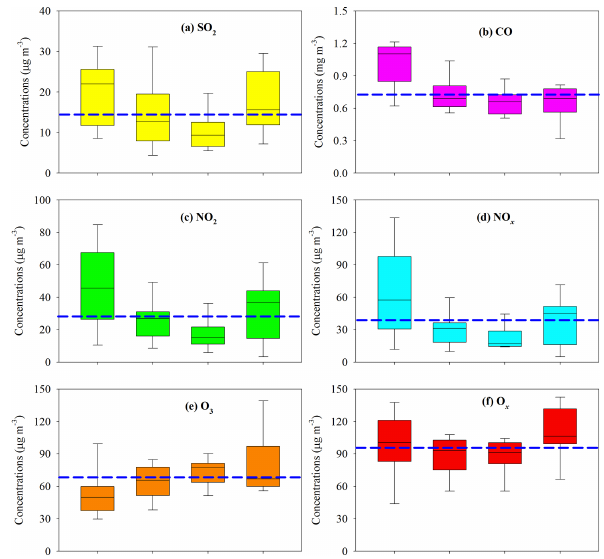
Figure 3. Seasonal variation of gaseous pollutants in the PRD. The boxes with error bars represent the 10th, 25th, 75th, and 90th percentiles for each pollutant. The line in each box represents the median value. The blue dashed lines indicate the annual av- erage concentrations of SO 2 (14.9µgm − 3 ) , CO (0.74mgm − 3 ) , NO 2 (28.5µgm − 3 ) , NO x (39.0µgm − 3 ) , O 3 (67.7µgm − 3 ) , and O x (96.1µgm − 3 )